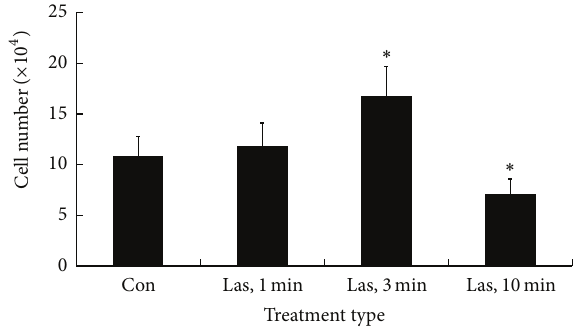
Figure 3: Effects of LPLI with different irradiation times on myoblasts myogenic differentiation ability as indicated by myotube formation rate (MFR). The data were from three independent experiments. ∗ 𝑃 < 0.05 as compared with control group. Undiff: undifferentiated cells cultured in growth medium; Con: control; Las: laser